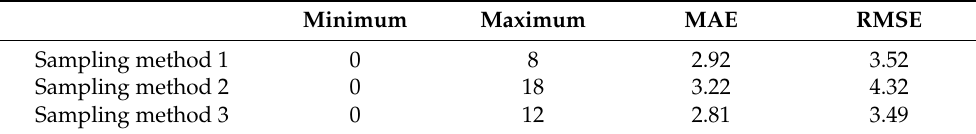
Table 4. Accuracy of heading dates estimated using UAV images (days).